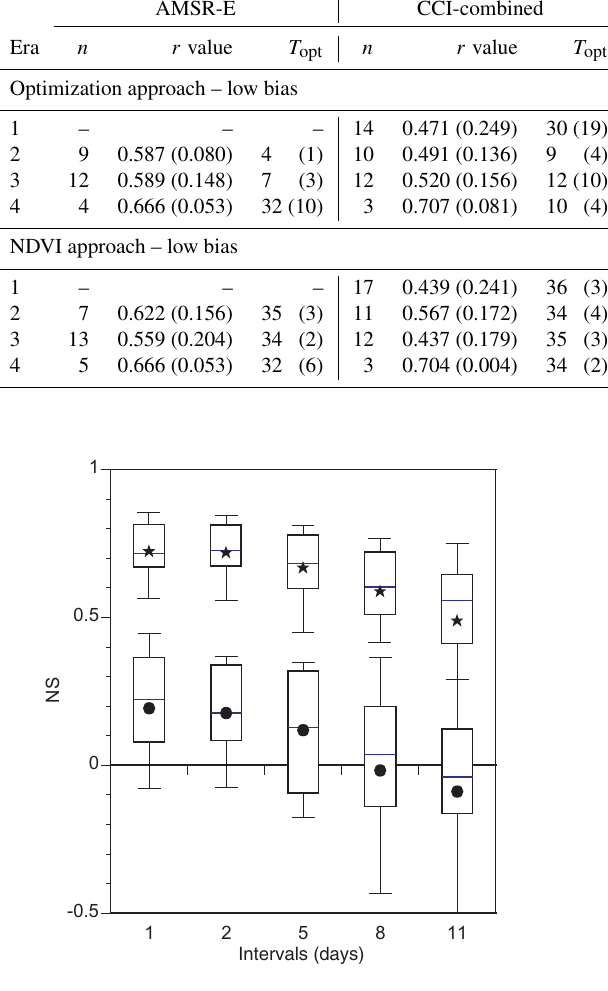
Figure 3. Box plot of the data denial experiment from the SCAN network during era 3 (2005–2008). Results for day 1 represent base- line data for the exponential filter driven by surface soil moisture data (in situ data: (cid:70) ; low absolute bias RMSE-optimized AMSR- E: • ). Other time series were altered to include only data at 2-, 5-, 8-, and 11-day